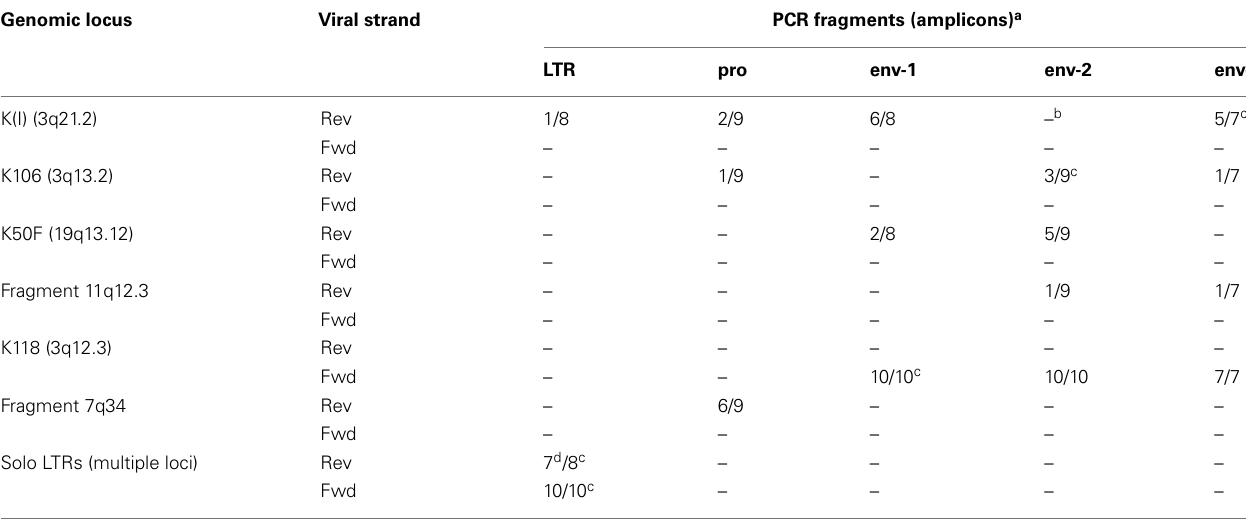
Table 4 | Human endogenous retrovirus K proviruses detected in LNCaP cells by sequencing plasmid subclones. Genomic